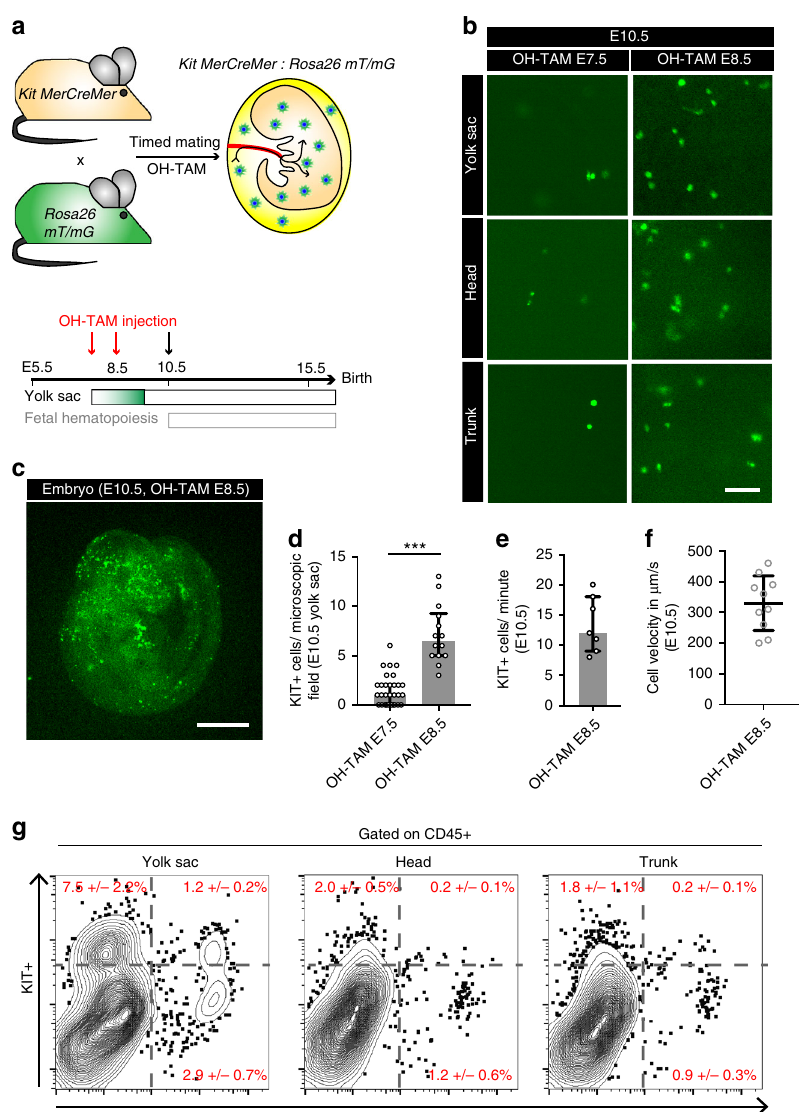
Fig. 7 Traf fi cking of KIT+ EMPs. a Schematic graph for the Kit MerCreMer :Rosa26 mT/mG mouse model with OH-TAM pulse labeling at E7.5 or E8.5 (red arrows) and subsequent analyses at E10.5 (black arrow). b – d Fluorescent pictures of KIT+ cells in the YS and embryo on E10.5 after pulse labeling at indicated time points ( b , c ) with corresponding quanti fi cations ( d ); *** p < 0.001 (Mann – Whitney test); median ± IQR. e Quanti fi cation of labeled KIT+ cells/min in an average-sized YS vessel at E10.5; median ± IQR. f Velocity of intravascular non-adhering KIT+ cells in the YS at E10.5; mean ± SD. g Flow cytometry plots of CD45+ gated KIT+ vs. GFP+ cells from pulse-labeled Kit MerCreMer :Rosa26 mT/mG mice in YS, head and trunk region at E10.5. Plots show an individual representative experiment. At least 3 embryos of minimum 2 independent litters were analyzed per time point. Scale bars are 100 µ m ( b ), 1 mm ( c